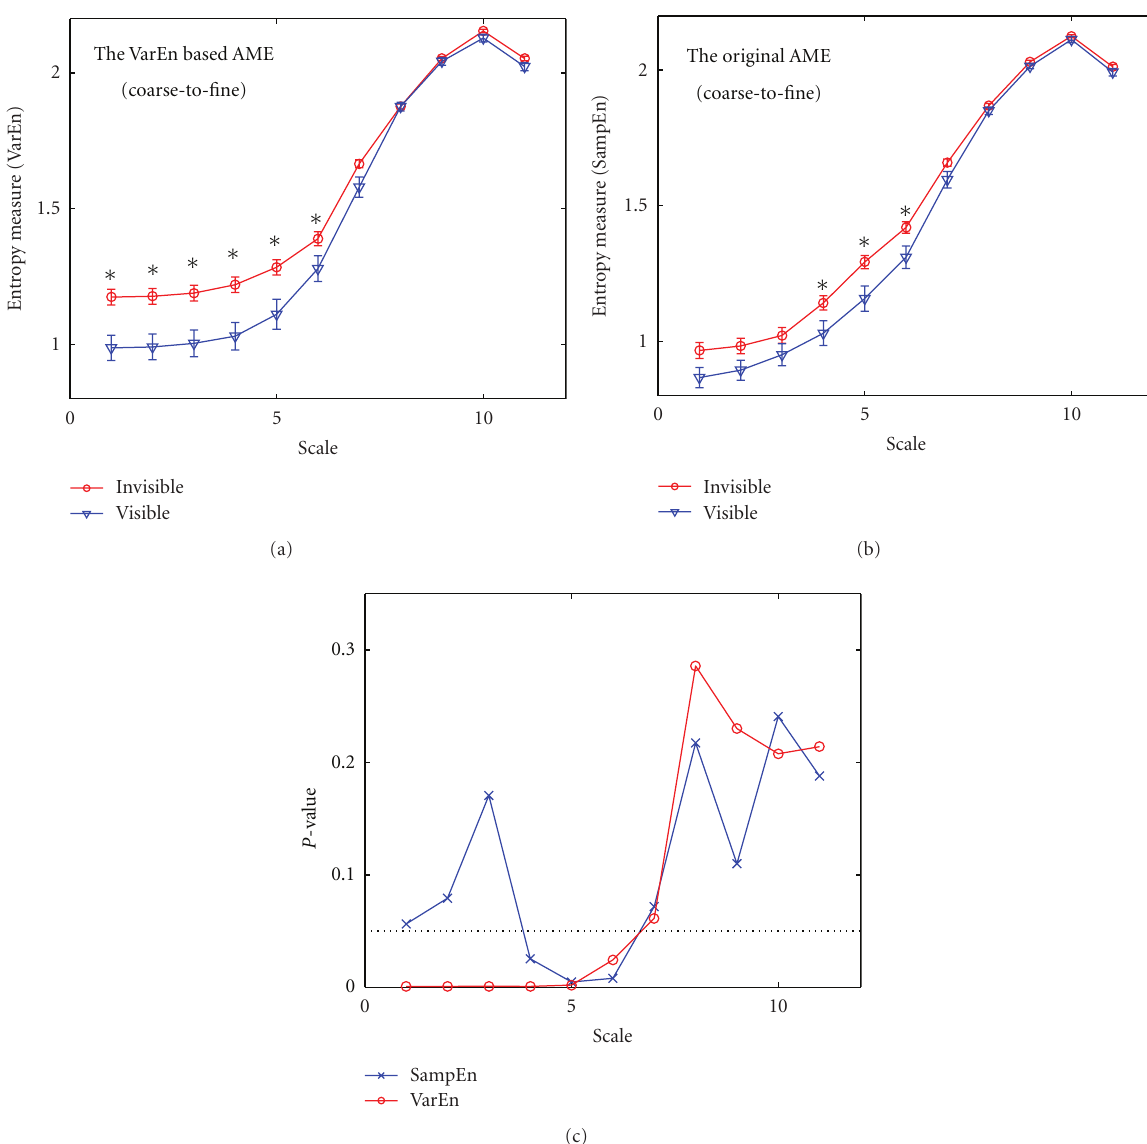
Figure 3: Coarse-to-fine comparison for the AME with VarEn (a) and the AME with SampEn (b) for discriminating the Invisible (red circle) and the Visible conditions (blue triangle) over multiple scales. The error bar refers to the standard error of mean. The leftmost red circle and blue triangle are the entropy measures of the raw data. For the AME with VarEn (a), significant di ff erences occur at the 1st–6th scales, while the significant di ff erences only occur at the 4th–6th scales for the AME with SampEn (b). The sign “ ∗ (cid:4)(cid:4) refers to P < 0 . 05. The P values based on our VarEn and the SampEn along the coarse-to-fine scales are also compared (c), in which the horizontal black dotted line refers to the significance level ( P = 0 .